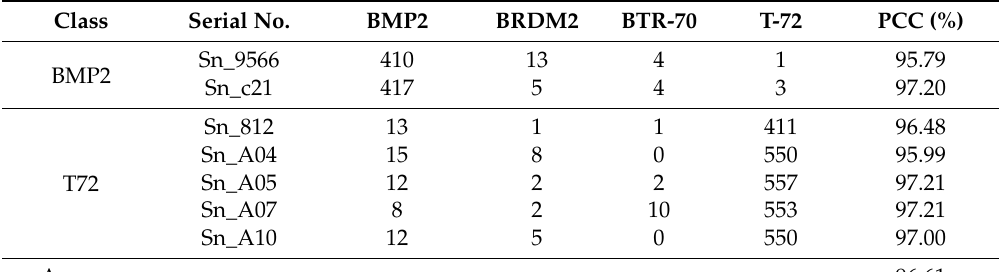
Figure 8. Optical and synthetic aperture radar (SAR) images of four configurations of T72 tank. ( a ) Optical images ( b ) SAR images. Table 6. Recognition results of the proposed method under configuration variance. PCC: percentage of correct classification.